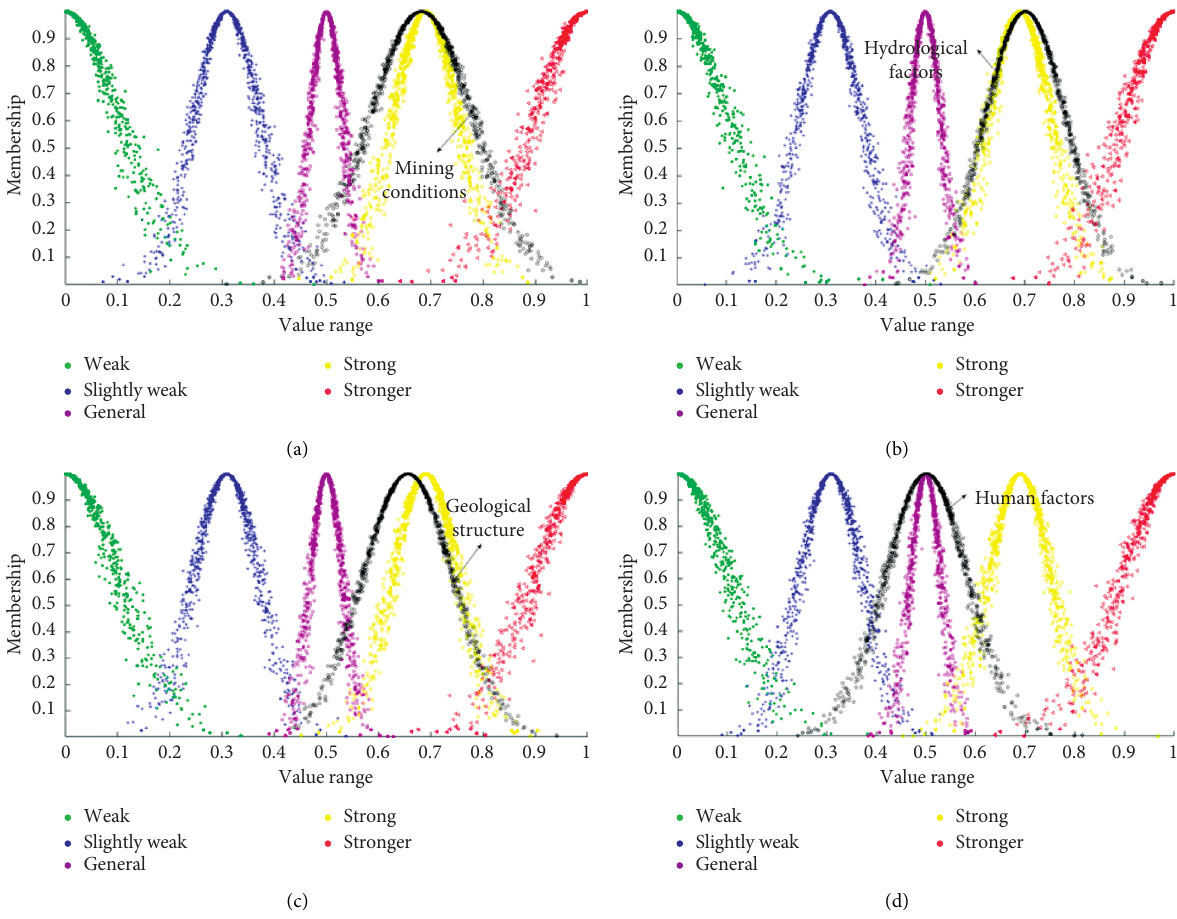
Figure 9: The cloud model evaluation results of first-level indicators. (a) Mining conditions evaluation cloud. (b) Hydrological factor evaluation cloud. (c) Geological structure evaluation cloud. (d) Human factors evaluation cloud.